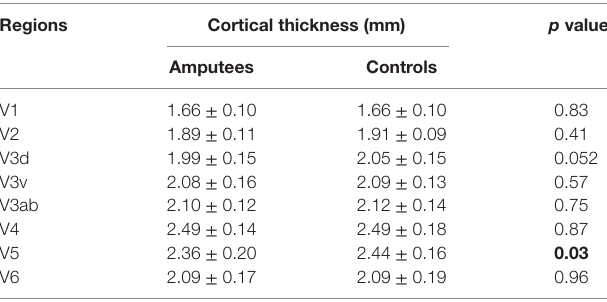
TaBle 2 | comparison of cortical thickness in the visual regions. regions